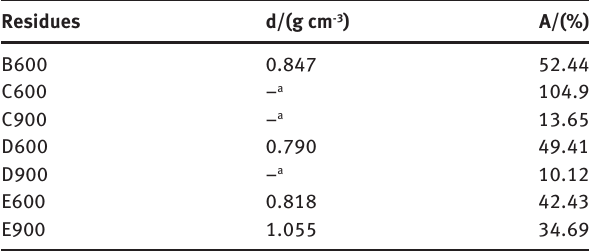
Table 4: Bulk density and water absorption of ceramic residues with different components at different